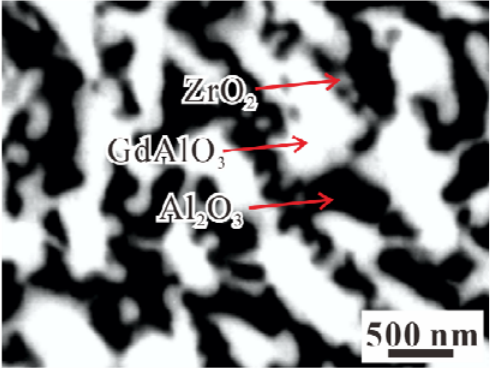
Fig. 9 Magnified picture of the microstructure of the laser 3D-printed Al 2 O 3 /GdAlO 3 /ZrO 2 eutectic